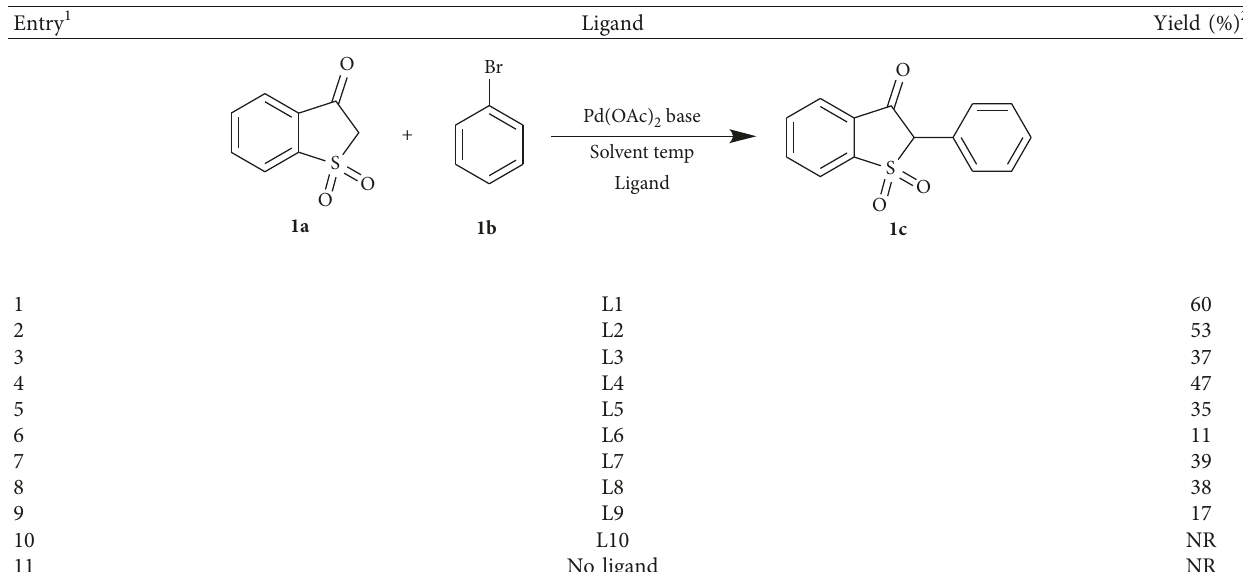
Table 1: Optimization of phosphine ligands.